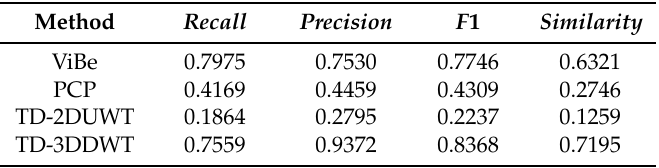
Table 12. Comparison of average metrics for the skating